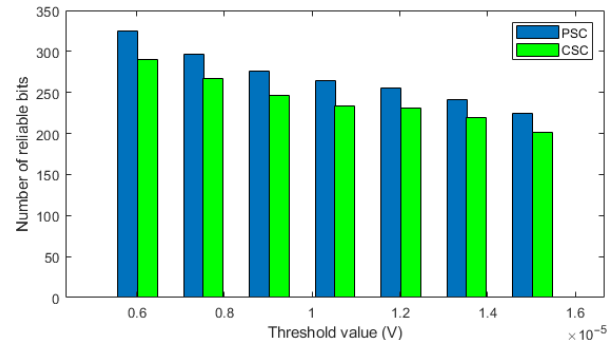
Figure 9. Comparison of generated bits using PSC and CSC for SCN-PUF data.